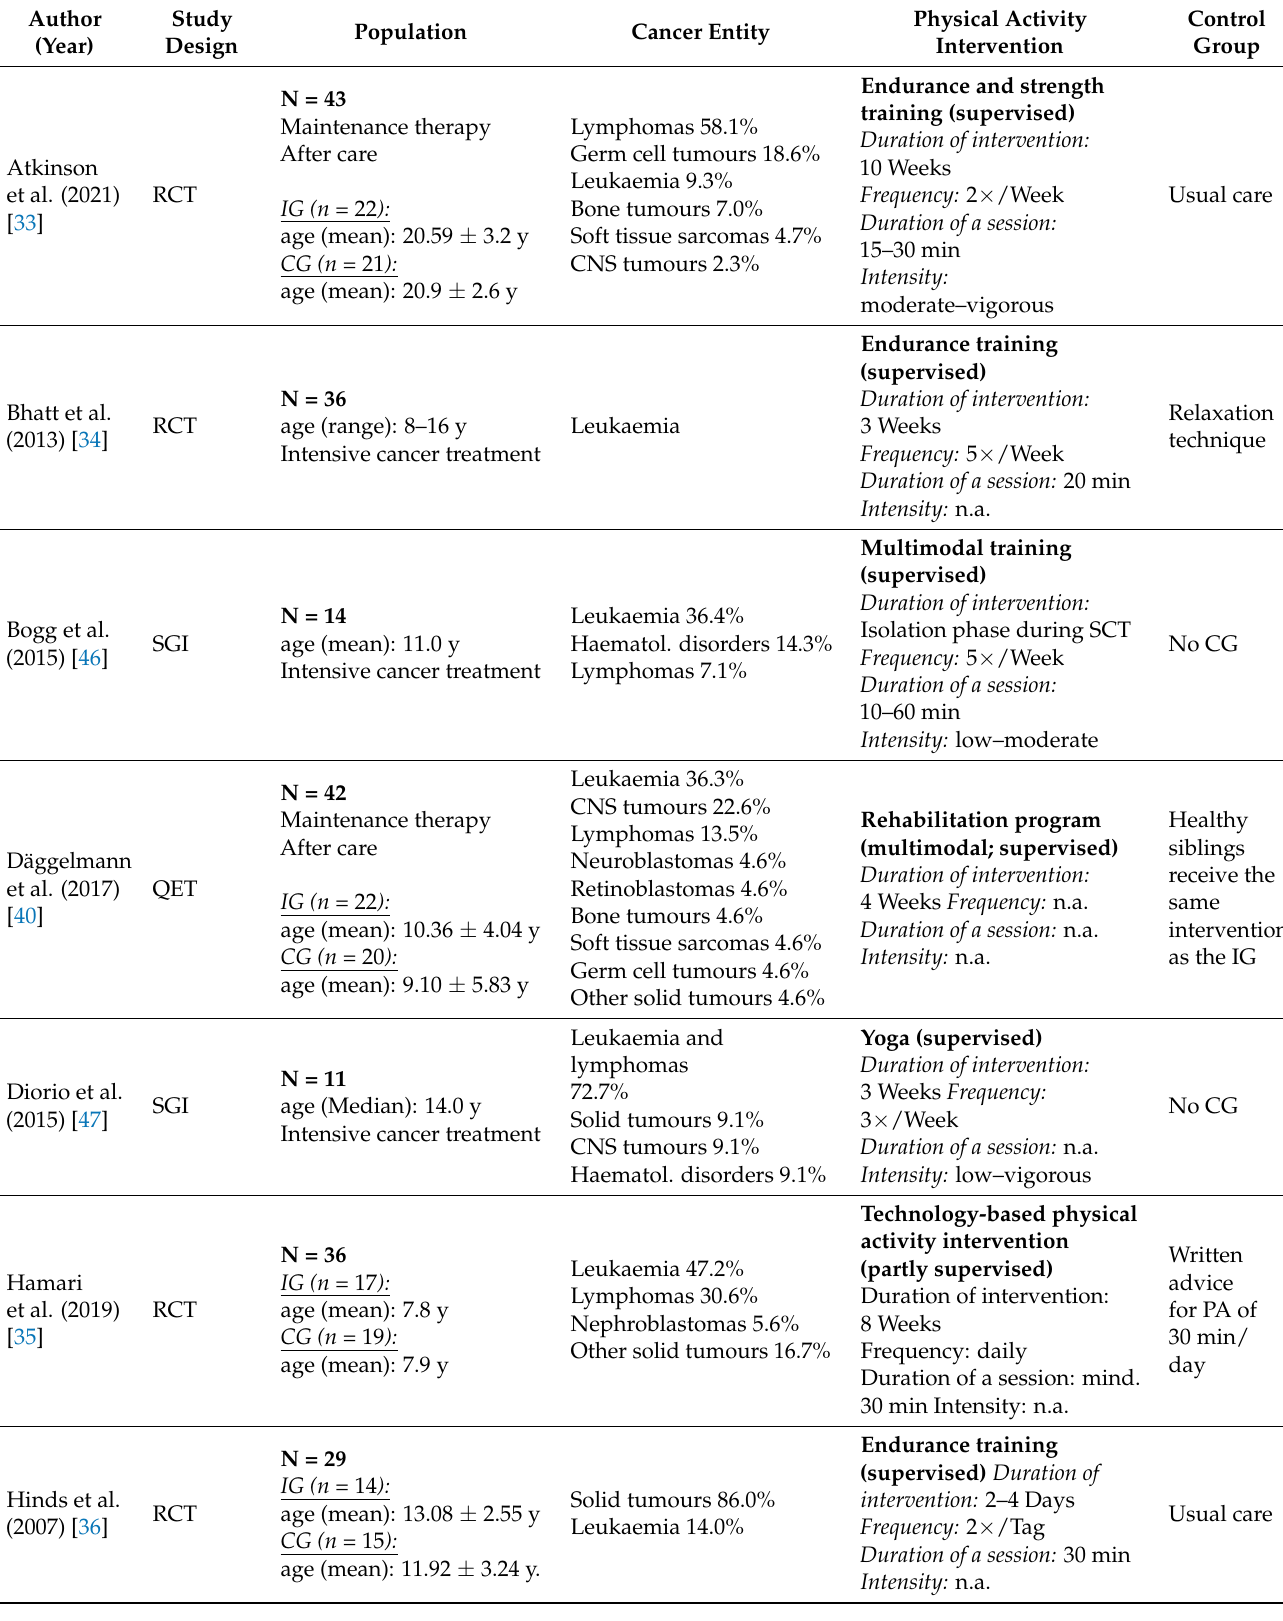
Table 1. Characteristics of included